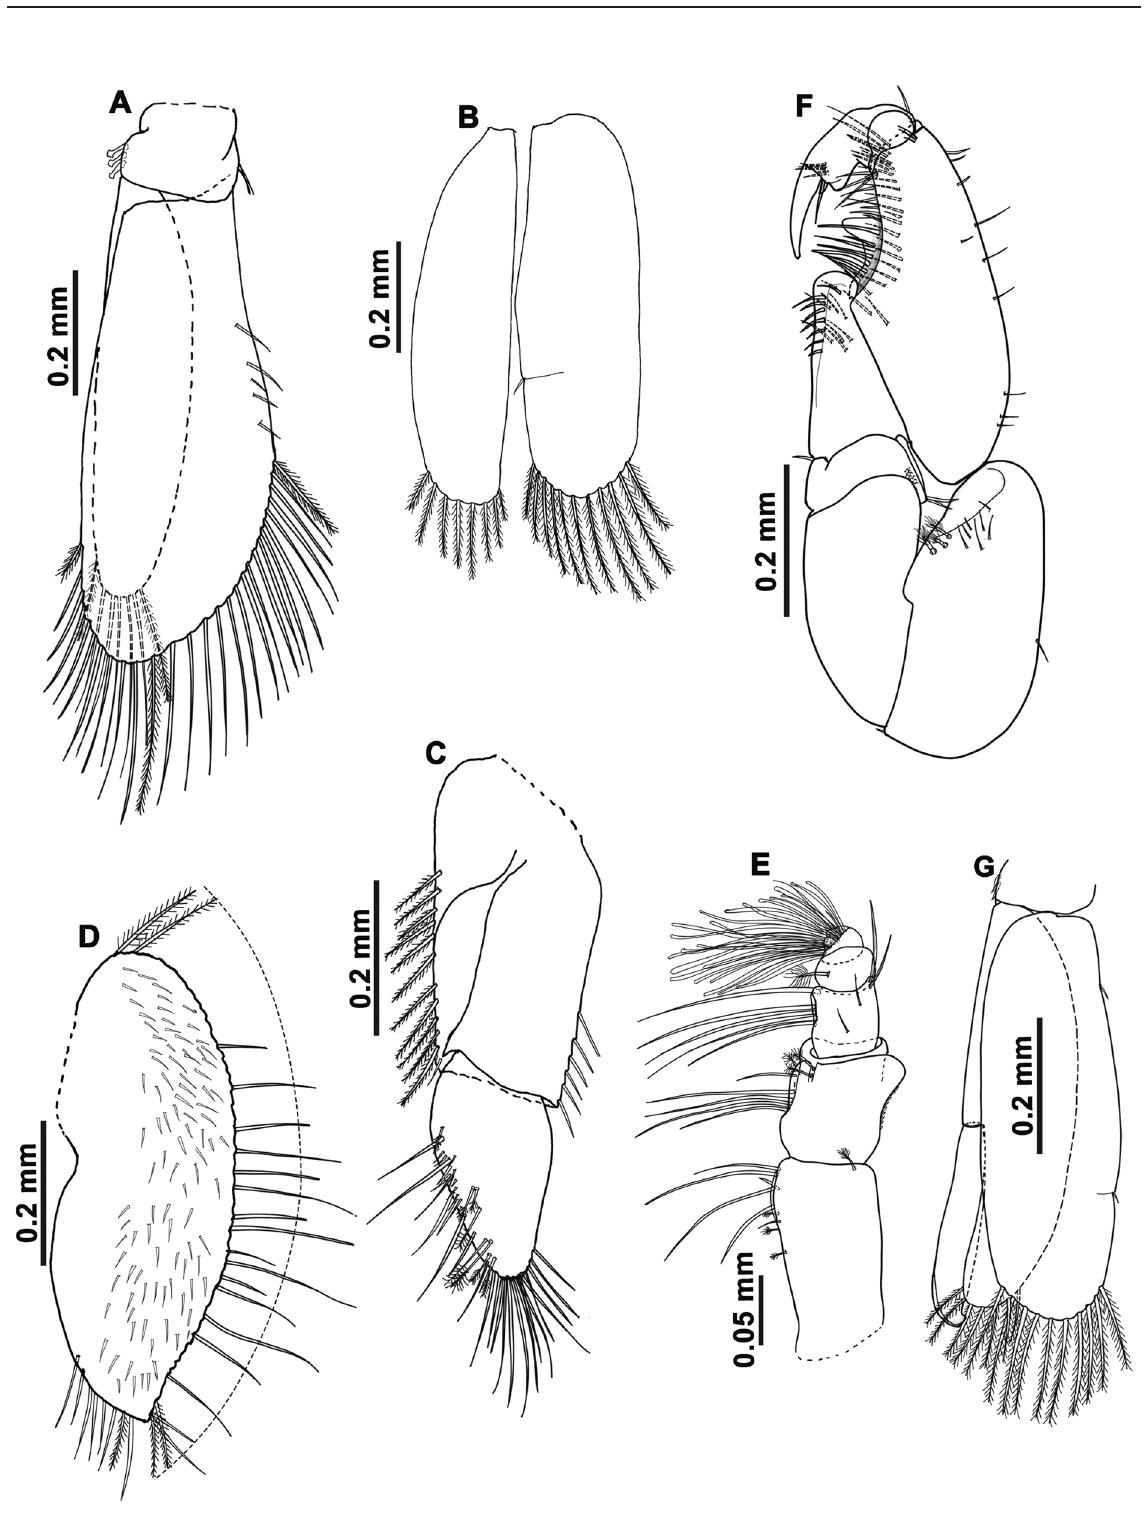
Fig. 7. Cortezura caeca sp. nov. A–D . Holotype, ♀, 7.1 mm, Oaxaca, Huatulco, Jicaral Beach (UMAR- PERA 534). A . Pleopod 1. B . Pleopod 2. C . Uropodal endopod. D . Uropodal exopod. E–G . Paratype ♂, 8 mm (UMAR-PERA 535). E . Antennule. F . Pereopod 1. G . Pleopod